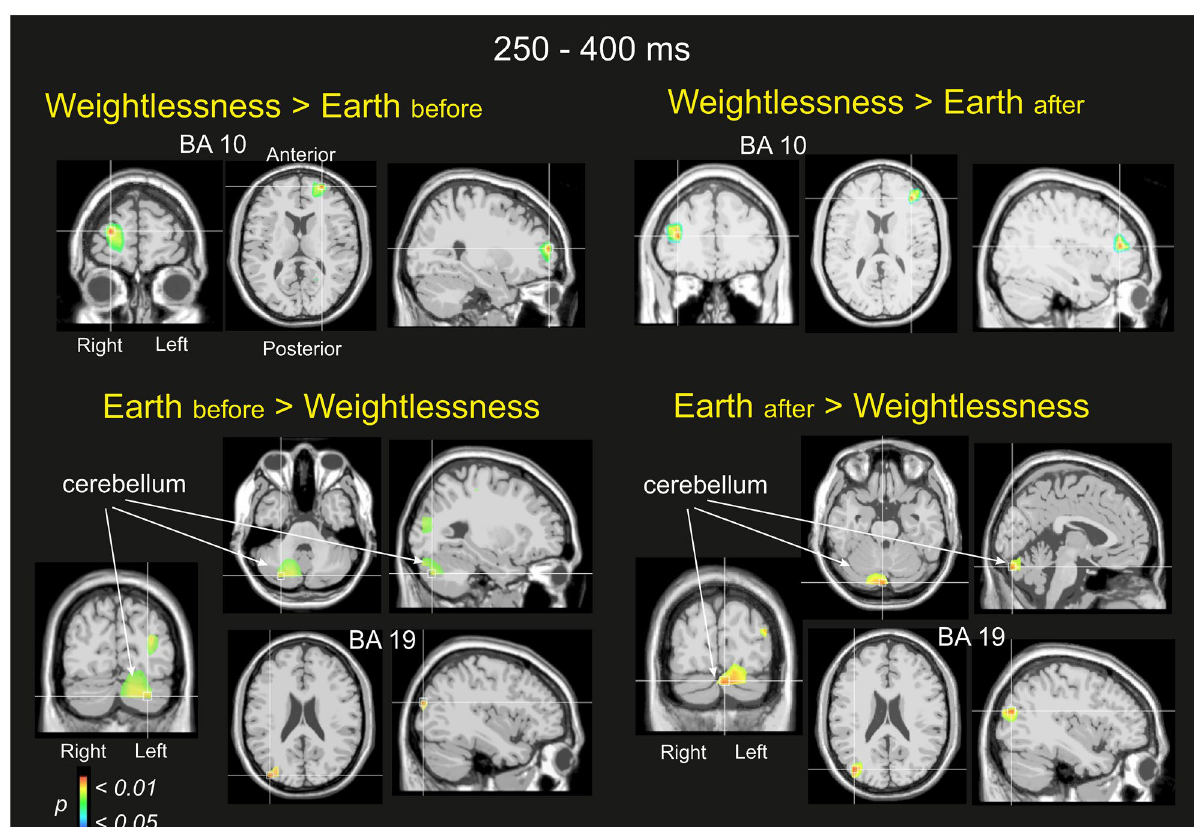
Figure 3. Sources estimations during the P300 component (250–400 ms period). Nonparametric statistical maps calculated on the five astronauts for the Weightlessness > Earthbefore and Weightlessness > Earthafter contrasts, in the upper part of the figure and Earthbefore > Weightlessness and Earthafter > Weightlessness in the lower part of the figure. Note major B10 activation during Weightlessness (for both contrasts > Earthbefore or after), and cerebellum and BA 19 major activations on Earth (indifferently whether Earthbefore > Weightlessness or Earthafter >